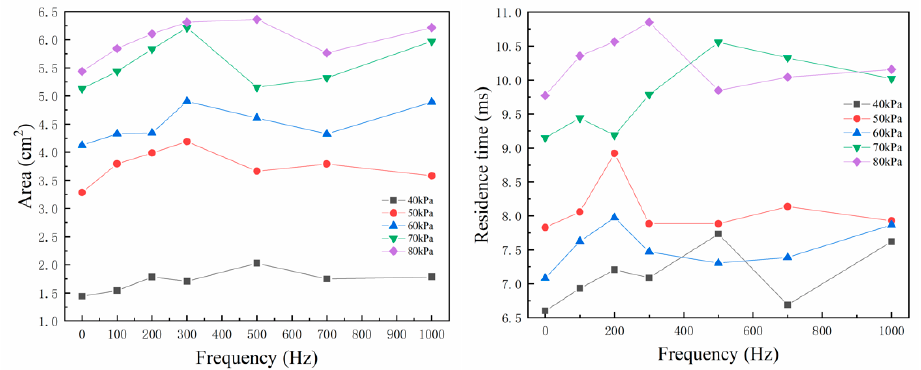
Figure 22. Low-velocity-region areas ( left ) and fuel-air-mixture residence times ( right ) for different pressures and discharge frequencies.